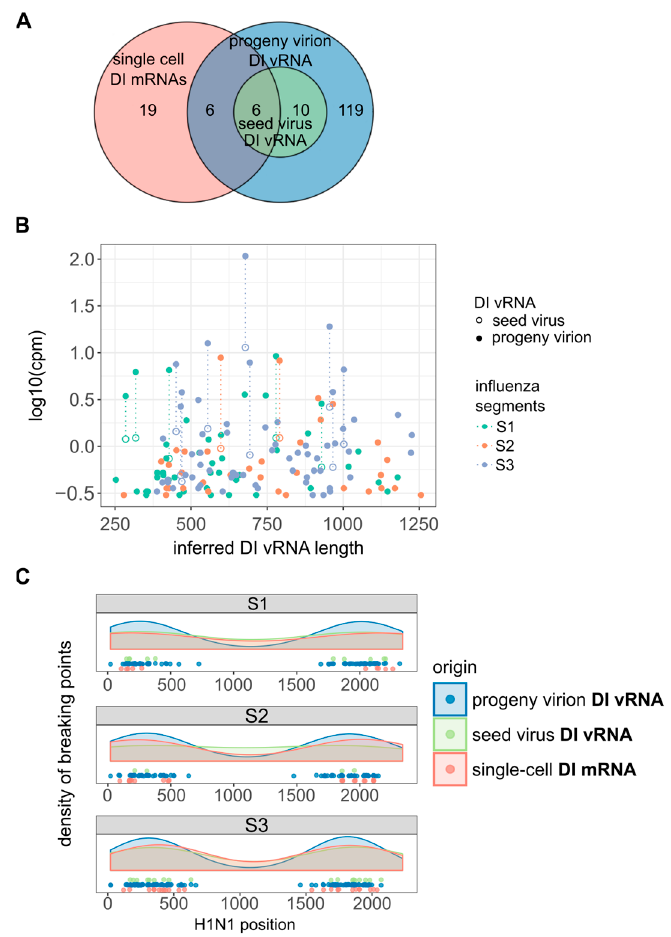
Figure 5. De novo generation of DI vRNAs. De novo generation was studied at the population and single-cell level. MDCK cells were infected with PR8 virus at an MOI of 10, and incubated until 12 hpi for cell population-based studies, or cells were trypsinized to facilitate single cell isolation (as shown in Figure 1) and incubation until 12 hpi. Seed virus vRNAs and vRNAs of progeny virions (produced in cell population-based infections) were analyzed by bulk RNA-seq. Single-cell intracellular viral mRNAs were investigated via scRNA-seq. Chimeric reads spanning the deleted region were used to identify the distinct DI vRNAs and DI mRNAs and to locate the deletion junction region (as shown in Figure 4A). The pooled data of multiple independent experiments are depicted ( n = 2 for population- and n = 3 for single cell-based experiments). ( A ) Venn diagram showing the number of distinct DI vRNAs in the seed virus and progeny virions, and of DI mRNAs in single cells. ( B ) Diversity in DI vRNA sizes in the seed virus and progeny virions and their expression level. The expression level of DI vRNAs was approximated by the normalized number of chimeric reads spanning the deletion junction. ( C ) Distribution of deletion junctions of DI vRNAs and DI mRNAs. Start and end position of the deletion junction are marked on the corresponding segment.